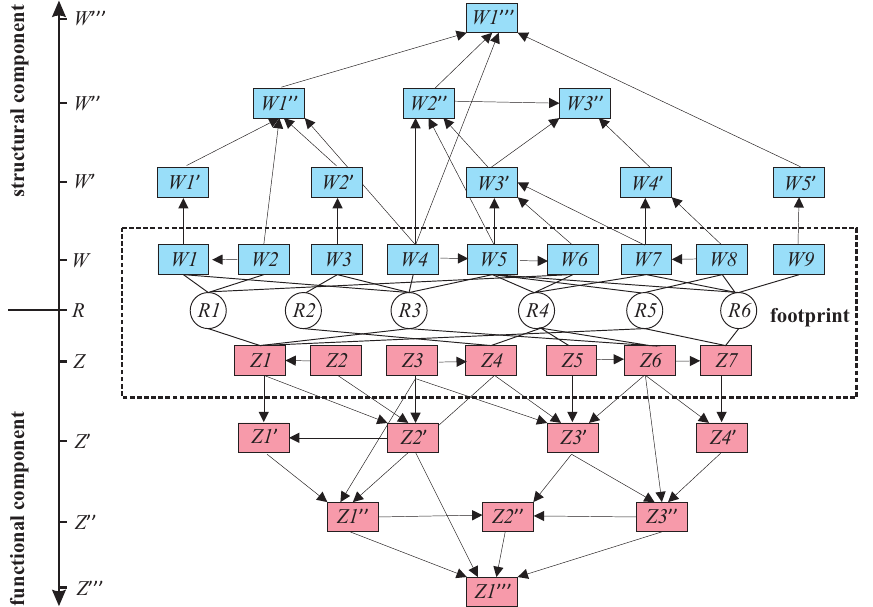
Figure 1. Representation of structural ( G w ), functional ( G z ), and operational ( G r ) data as a graph during formalization of data on a complex